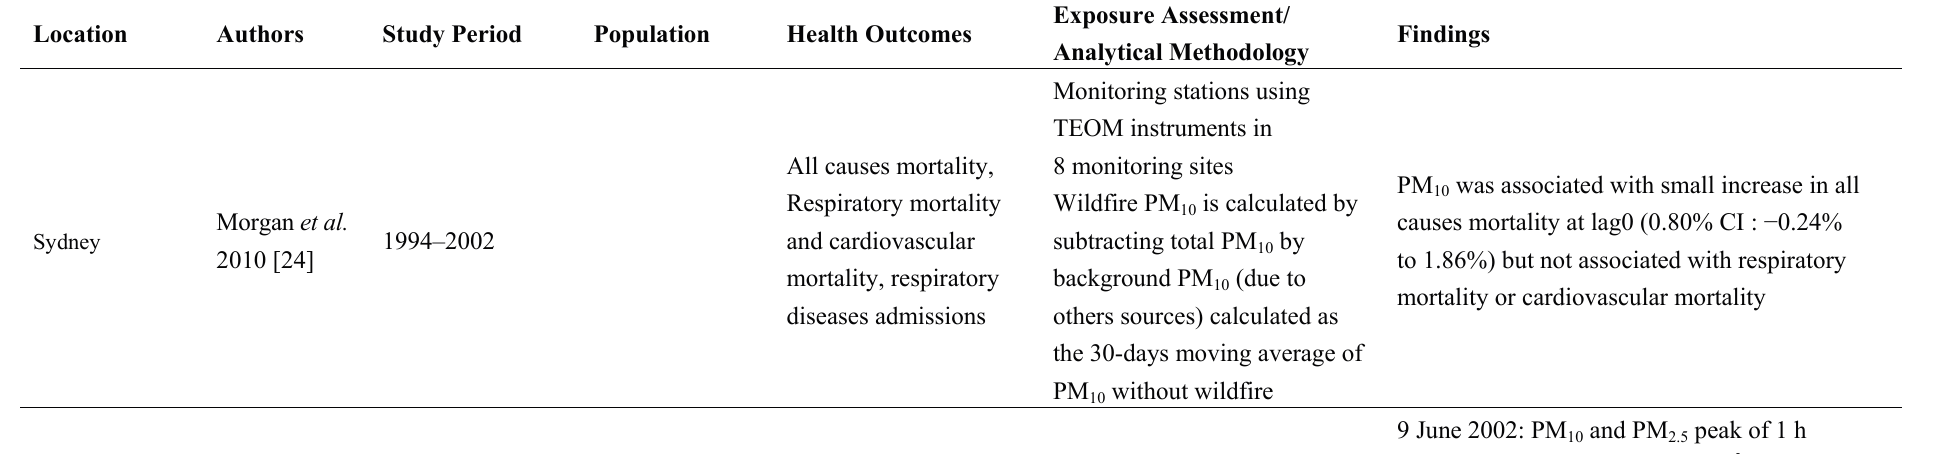
Table 1. Exposure to wildfire and non-accidental